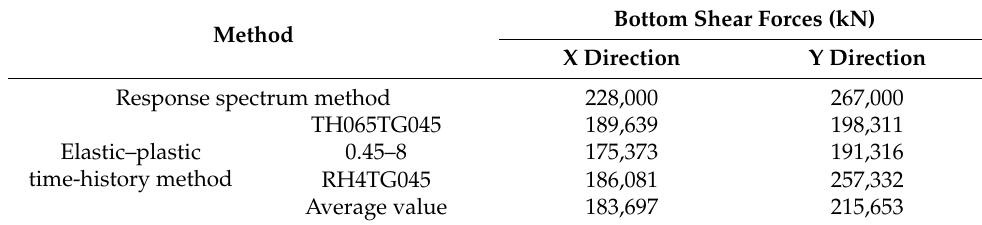
Table 16. Calculation results of the bottom shear forces.